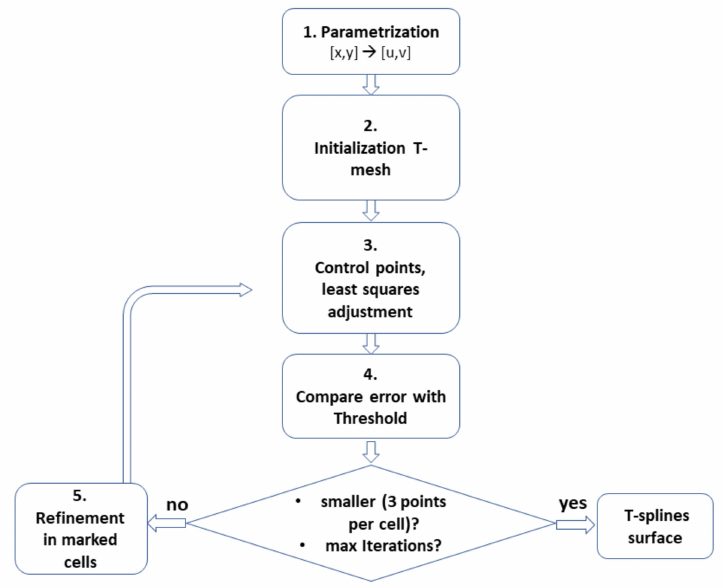
Figure 4. Methodology of the iterative refinement with